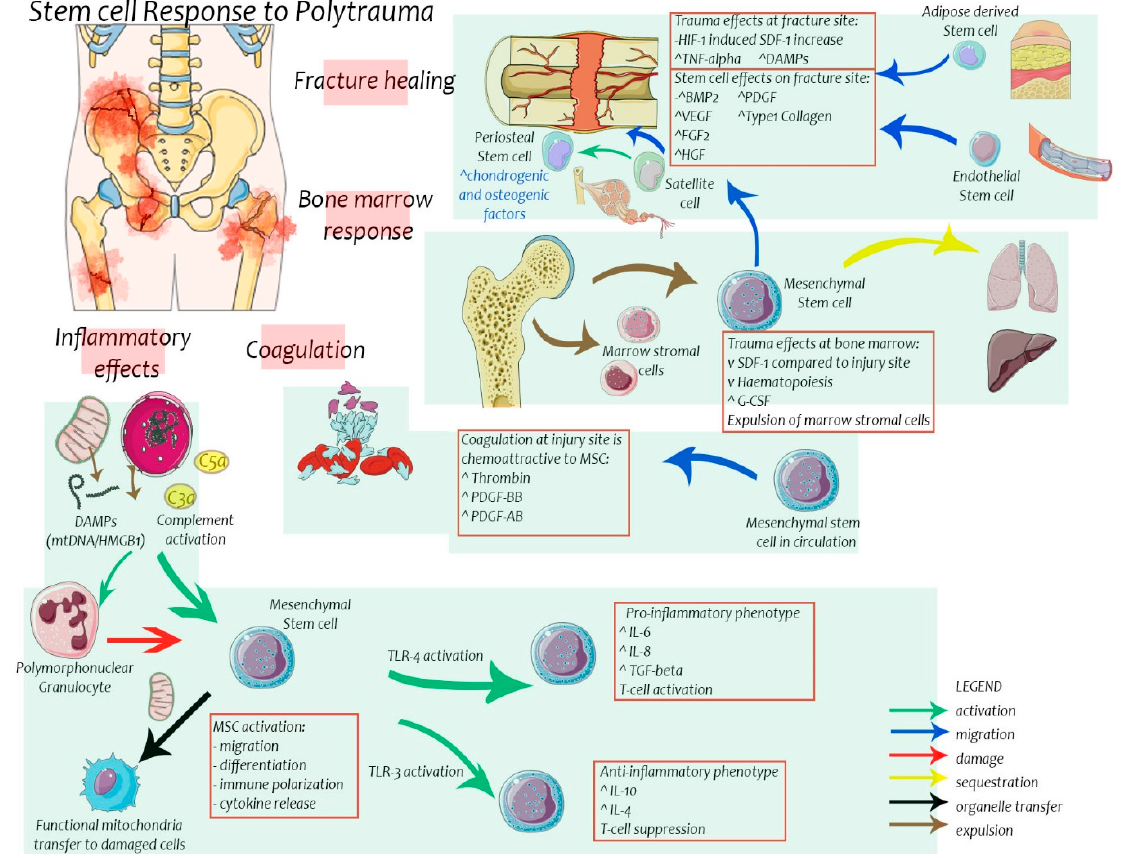
Figure 2. Various stem cell mechanisms are activated in response to severe injury. (1) Fracture healing involves multiple stem cells. Satellite cells play a vital role in activating Periosteal Stem Cells to release osteogenic and chondrogenic factors while also migrating to the fracture site to augment fracture healing directly. ADSC and ESC also migrate to the fracture site. (2) The SDF-1/CXCR4 axis facilitates migration of MSC away from bone marrow towards sites of injury. G-CSF (Granulocyte Colony Stimulating Factor) also favours release of stem cells from bone marrow. Severe injury is accompanied by bone marrow failure and expulsion of bone marrow stromal cells. Some of the circulating stem cells sequester in lung and liver parenchyma. (3) Coagulation occurs with the healing response to injury while severe trauma may result in coagulopathy. There is an increase in platelet factors and thrombin as a result, which is chemotactic to MSC. (4) Inflammation and immune activation follows injury and inadvertently involves stem cell function. DAMPs and complement proteins may activate and prime MSC while also stimulating Polymorphonuclear Granulocyte (PMN) to damage neighbouring MSCs. MSCs may be polarized into pro-inflammatory or anti-inflammatory phenotypes depending on the nature of Toll-like Receptor(TLR) activation. TLR-4 activation results in pro-inflammatory MSCs while TLR-3 activation gives rise to anti-inflammatory MSCs. MSCs also possess the ability to donate mitochondria to neighbouring damaged cells to improve cell survival.